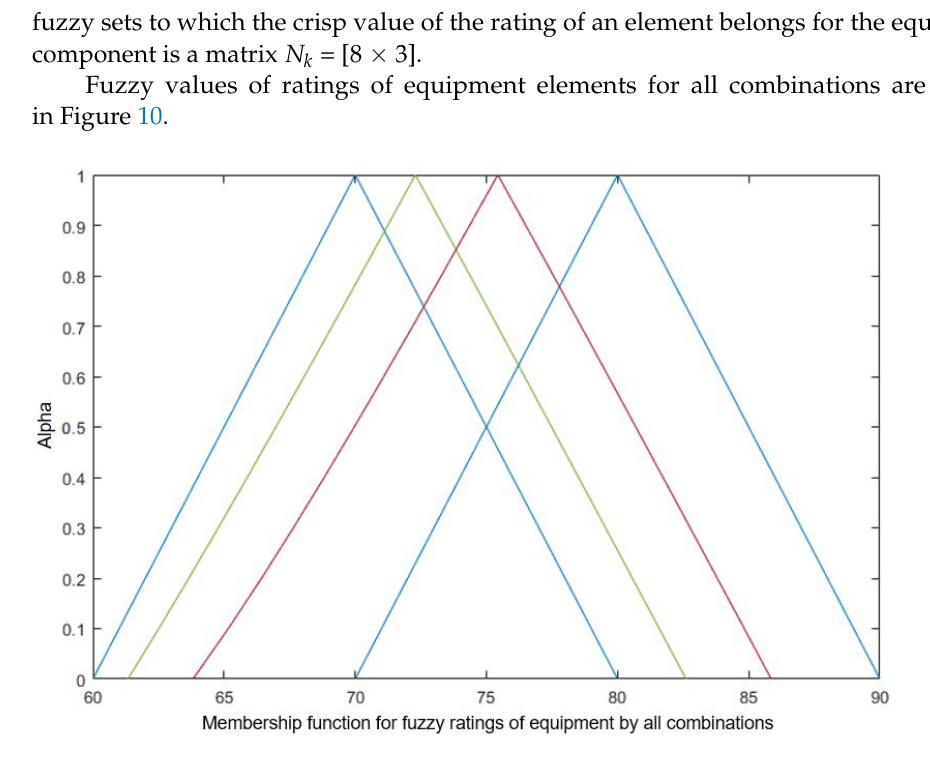
Table 13. The average of all combinations—the final fuzzy value of the equipment component rating.